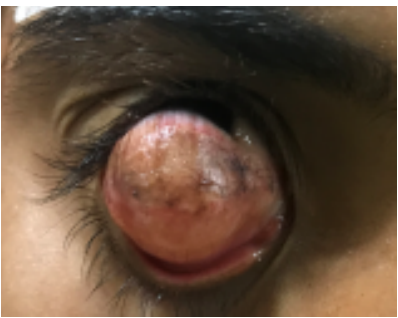
Figure 1: Giant limbal dermoid covering the cornea with pigmentation and fine